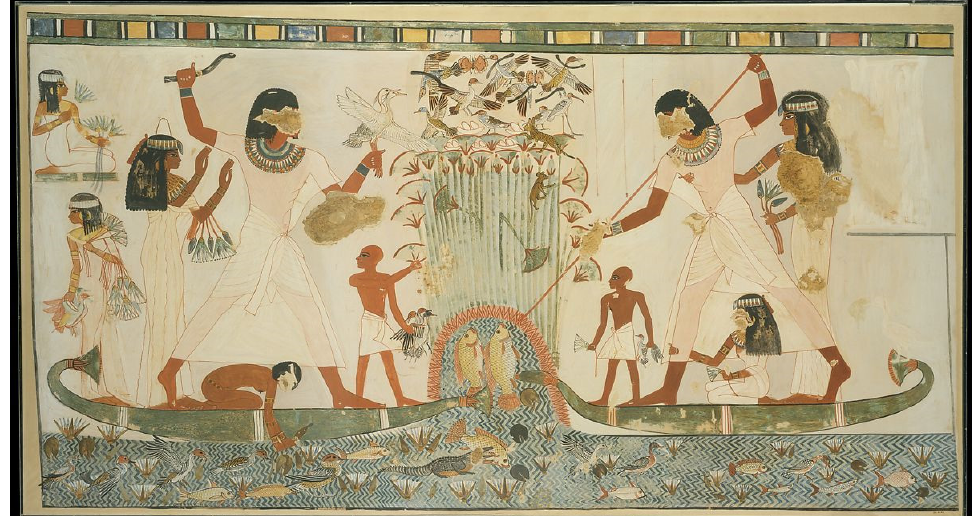
Figure 2. Facsimile painting of Menna and Family Hunting in the Marshes, Tomb of Menna. Nina de Garis Davies. Tempera on paper, 1924. Rogers Fund, 1930. Metropolitan Museum of Art, 30.4.48. Public Domain.